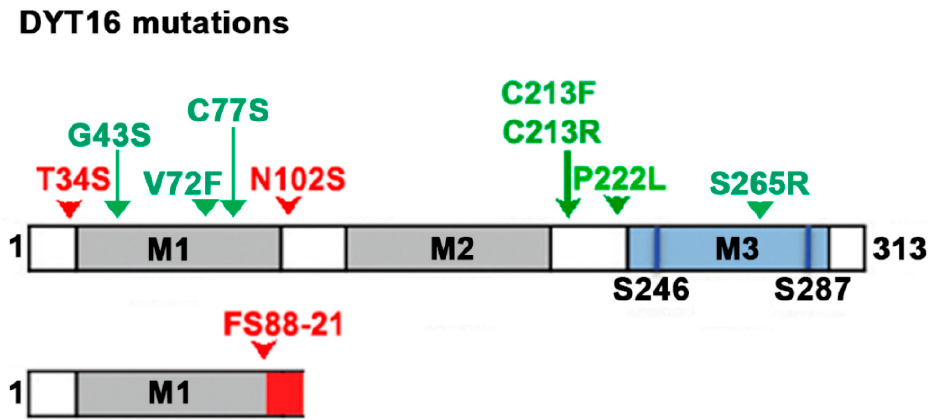
Figure 1. Schematic representation of DYT- PRKRA mutations: of the three conserved dsRBMs, M1 and M2 are shown in grey and the third motif lacking dsRNA-binding (M3) is shaded blue with the two phosphorylation sites represented as dark blue lines. Dominant DYT- PRKRA mutations are indicated in red while recessive mutations are indicated in green. The dominant frameshift mutation truncates the protein after the first 88 amino acids with 21 extraneous amino acids (red) shown at the carboxy terminus.